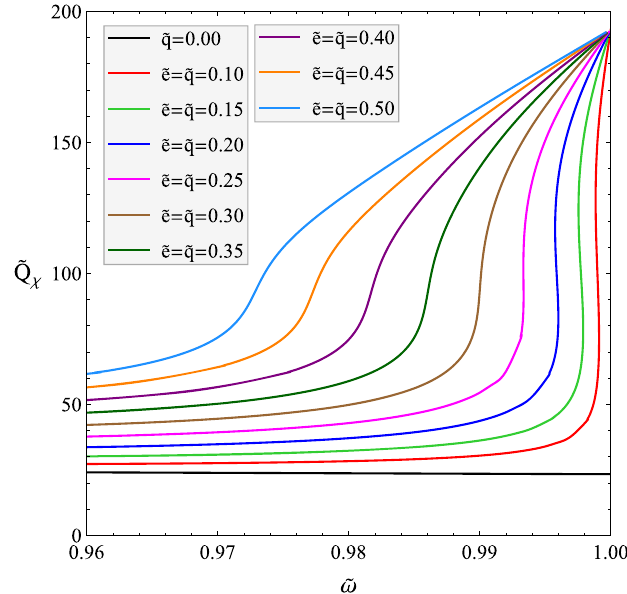
Fig. 3 The same as in Fig. 2, but for large values of the gauge coupling